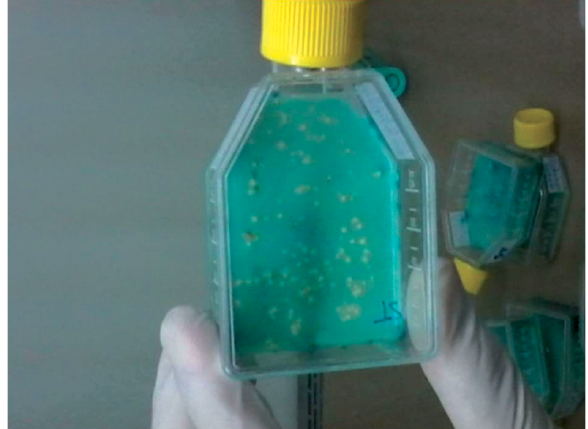
Figure 1. Sample 1ITVLRBM presenting typical growth of M. bovis colonies in solid. Stonebrink‑Leslie medium, example of the gold‑standard diagnostic test for tuberculosis.